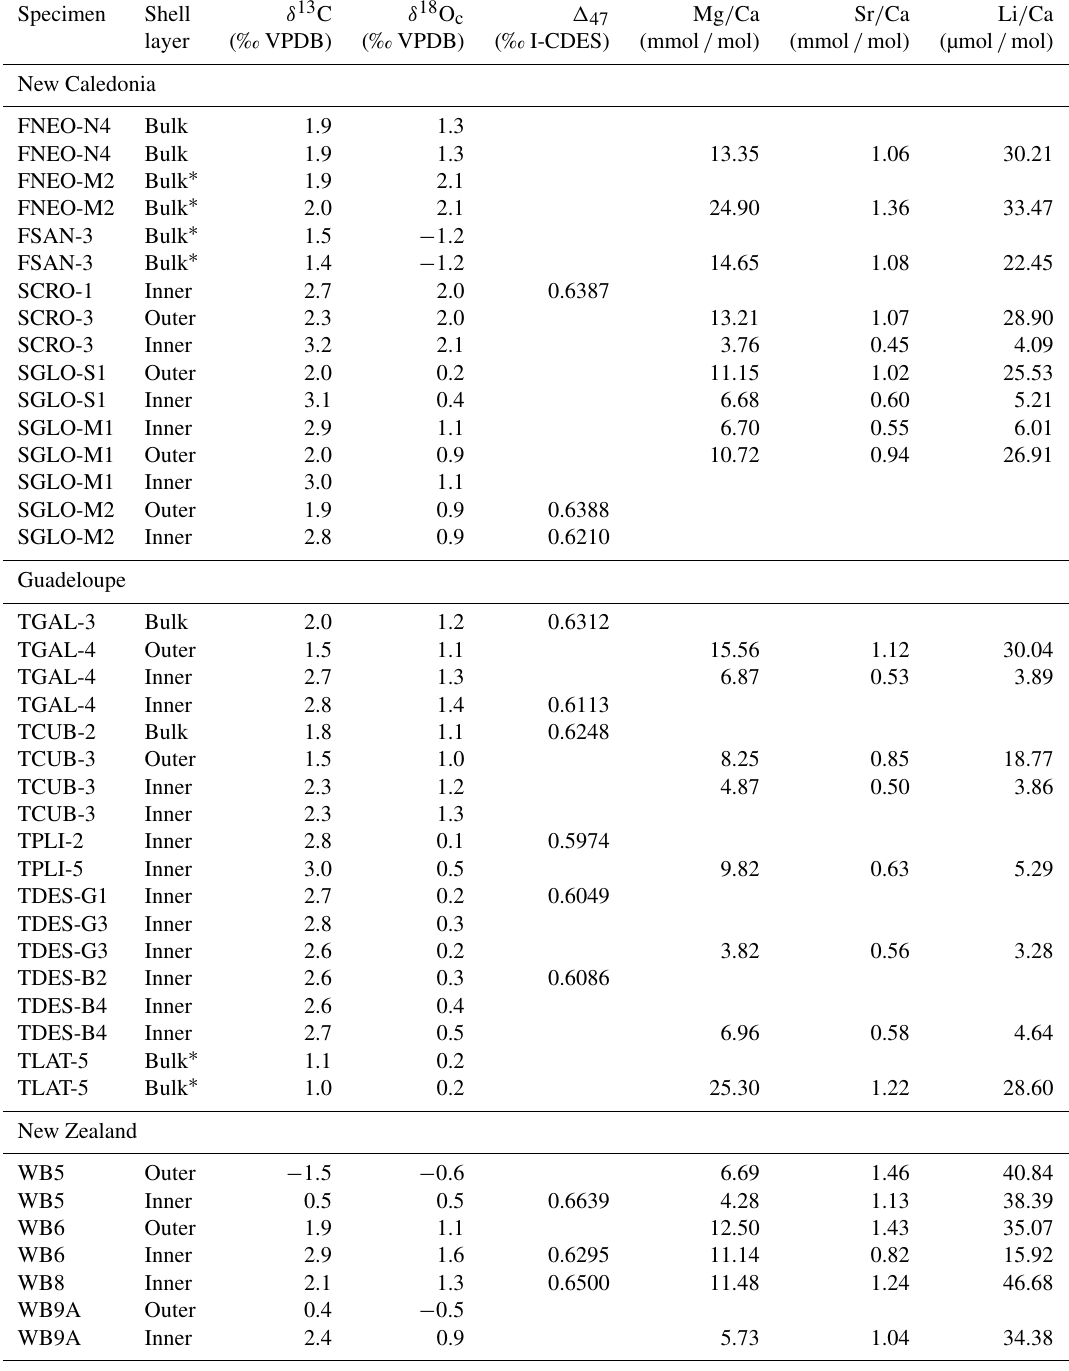
Table 2. Geochemical data of modern-brachiopod samples. Stable isotope values and element / Ca ratios.